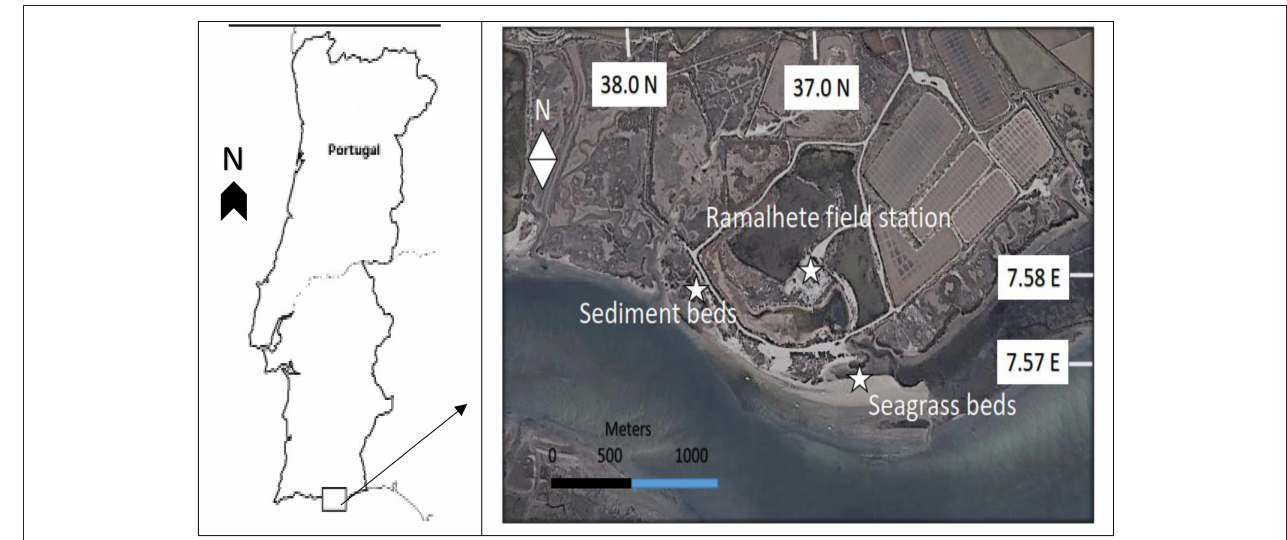
FIGURE 1 | Study area showing Zostera noltei beds and unvegetated sediment flats at Ria Formosa